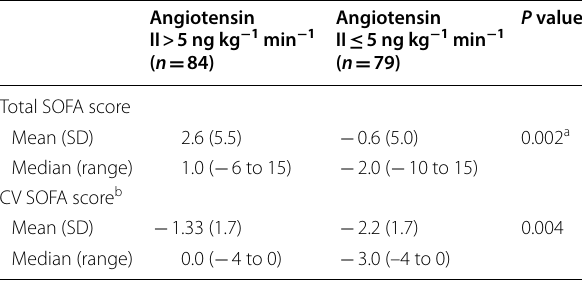
Table 2 Change from screening to hour 48 in total SOFA score and CV SOFA score